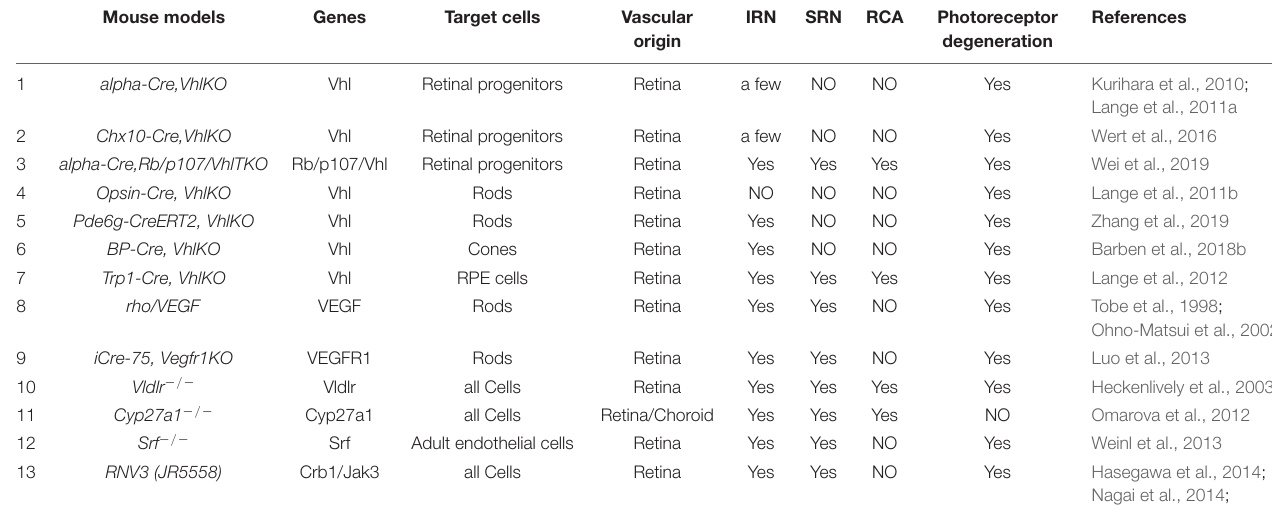
TABLE 1 | Animal models of